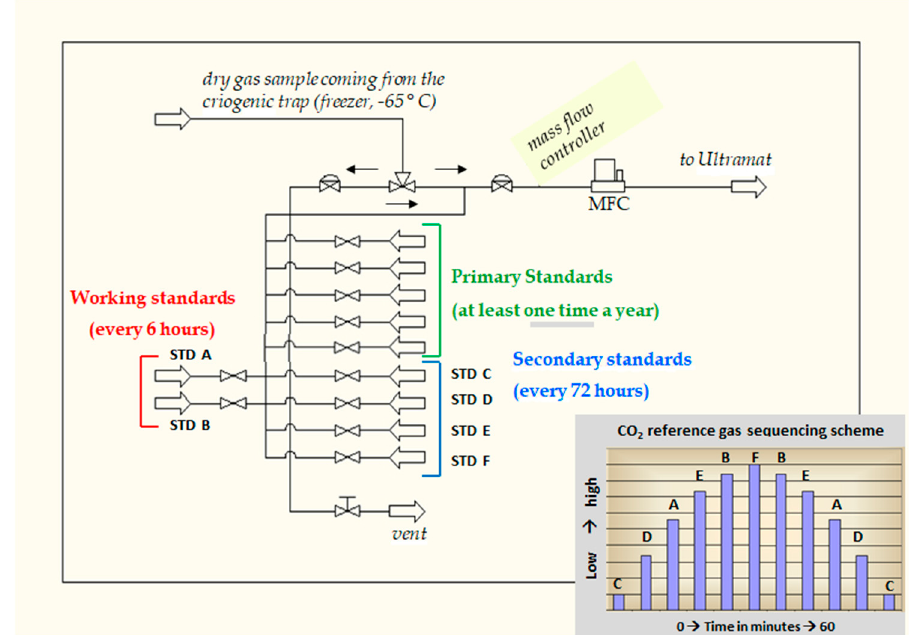
Figure 4. Measurement scheme (the CO 2 reference gas sequencing scheme is similar to the one proposed by Komhyr et al. [19]).